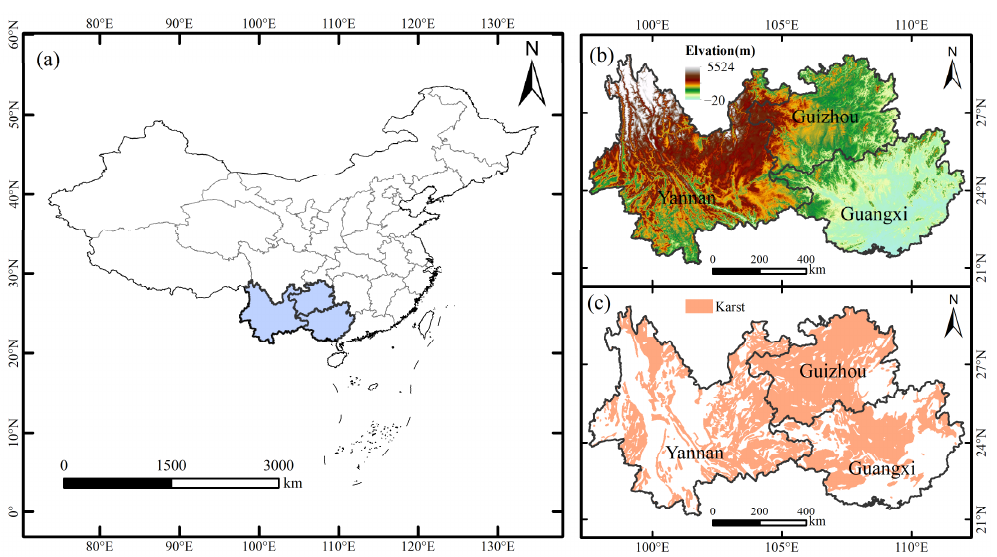
Figure 1. ( a ) Location of the study area in China. ( b ) Elevation of the study area. ( c ) Distribution of karst landforms in the study area.